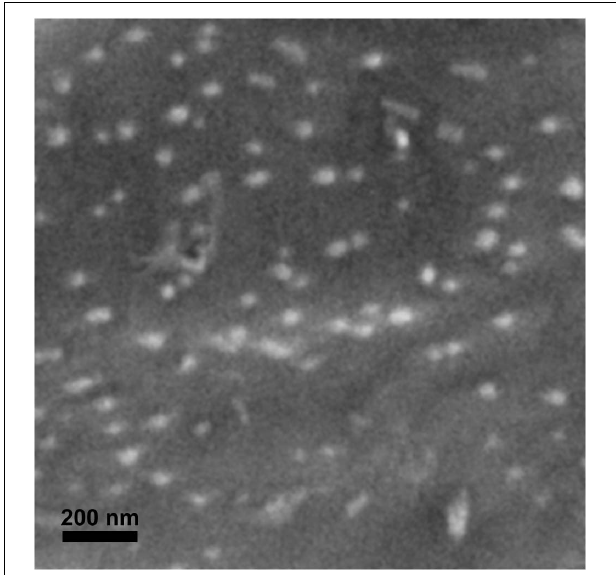
FIGURE 1 | Scanning electron microscopy image of dry nB 2 O 3 .